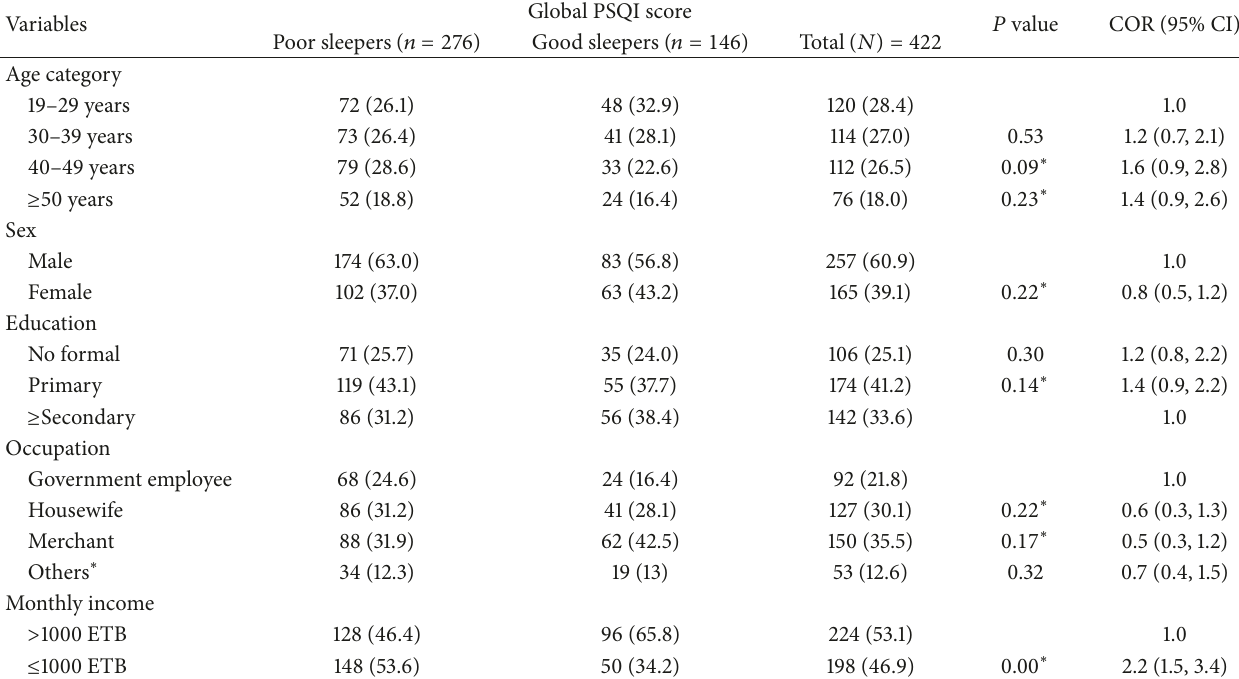
Table 3: Association between sociodemographic factors and poor sleep quality among sampled adults of Jimma town, April 2016.